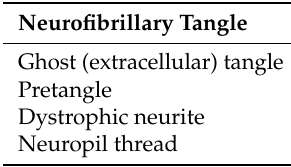
Figure 1. Bielschowsky silver stain ( left ) shows argyrophilia involving a neurofibrillary tangle and a neuritic plaque. P-tau immunohistochemistry using monoclonal antibody AT8 ( right ) shows neurofibrillary tangles and numerous neuropil threads. Table 2. Morphologic variations of